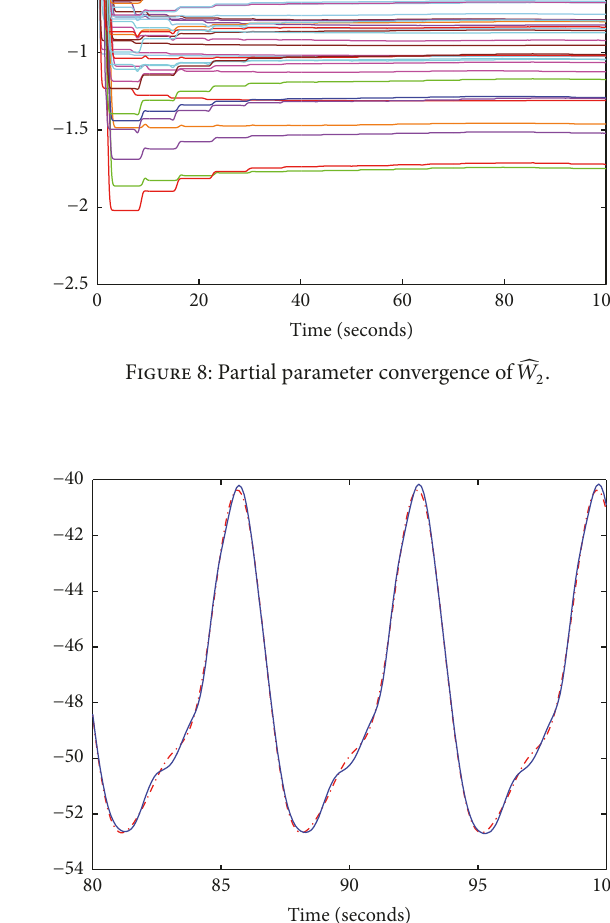
Figure 9: Function approximation: Φ 1 (𝑍) (—) and 𝑊